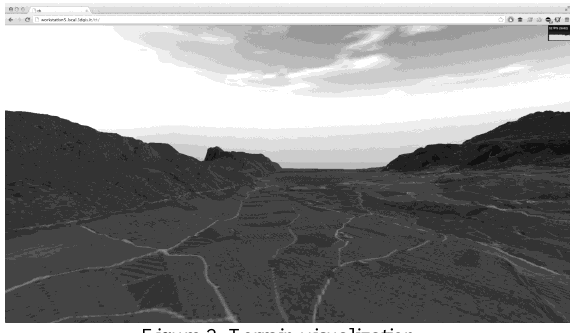
Figure 2. Terrain visualization.